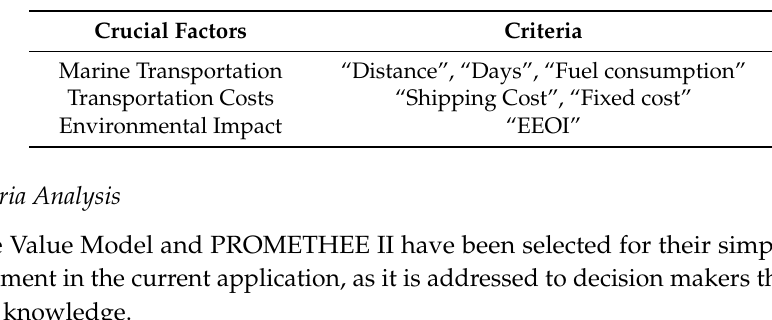
Table 1. The evaluation